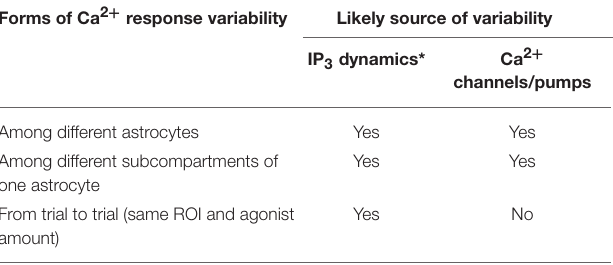
TABLE 2 | Experimentally observed variability in Ca 2 +